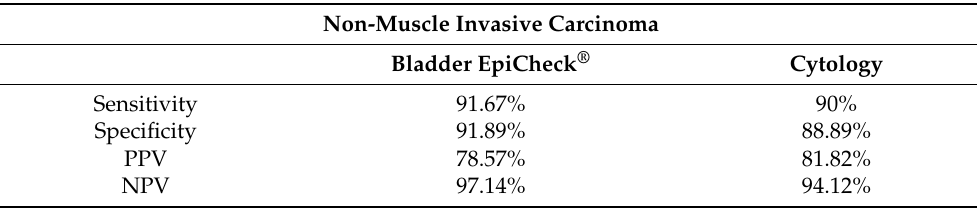
Table 2. Overall sensitivity, specificity, positive predictive value, and negative predictive value of bladder EpiCheck ® and cytology in follow-up non-muscle invasive bladder carcinoma. Table 3. Sensitivity, specificity, positive predictive value, and negative predictive value of bladder EpiCheck ® and cytology in high-grade urothelial carcinoma.